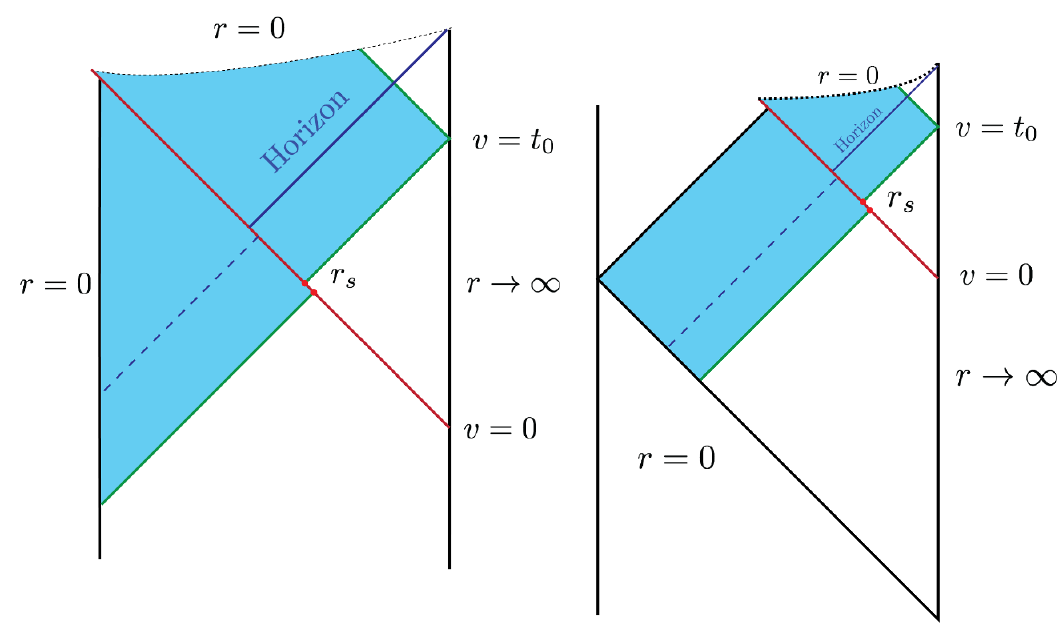
Figure 2 . Penrose-like diagrams for the thin shell collapsing geometries, we represent spherical horizon collapse from global AdS (left) and planar horizon from Poincar(cid:19)e patch (right). In order to not distort the diagrams, we represent the discontinuity in the outgoing coordinate u by a jump while crossing the collapsing shell, e.g., the dashed blue line indicates the extension of the event horizon into the region before the collapsing shell. We use r s to denote the radial position where the null boundary of the WDW patch crosses the shock